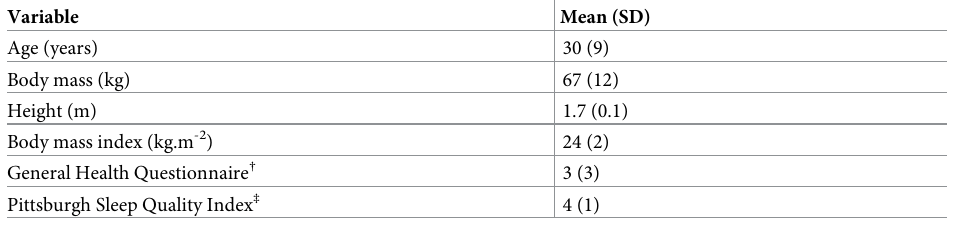
Table 1. Characteristics of the cohort prior to starting the first dietary intervention (n =